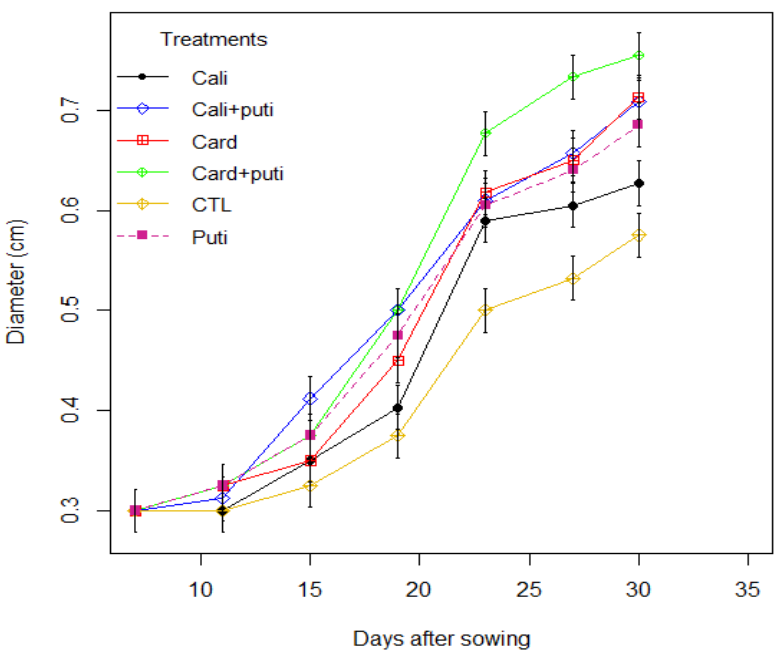
Figure 3. Plant diameter development as a function of treatments and over time. CTL = Control (Uncoated seed (without chitosan and P. putida ); Cali = Seeds coated with chitosan extracted from Callinectes amnicola ; Card = Seeds coated with chitosan extracted from Cardisoma armatum ; Puti = Seeds inoculated with Pseudomonas putida ; Cali + puti = Seeds coated with the combination of Callinectes amnicola + Pseudomonas putida ; Card + puti = Seeds coated with the combination of Cardisoma armatum + Pseudomonas putida .